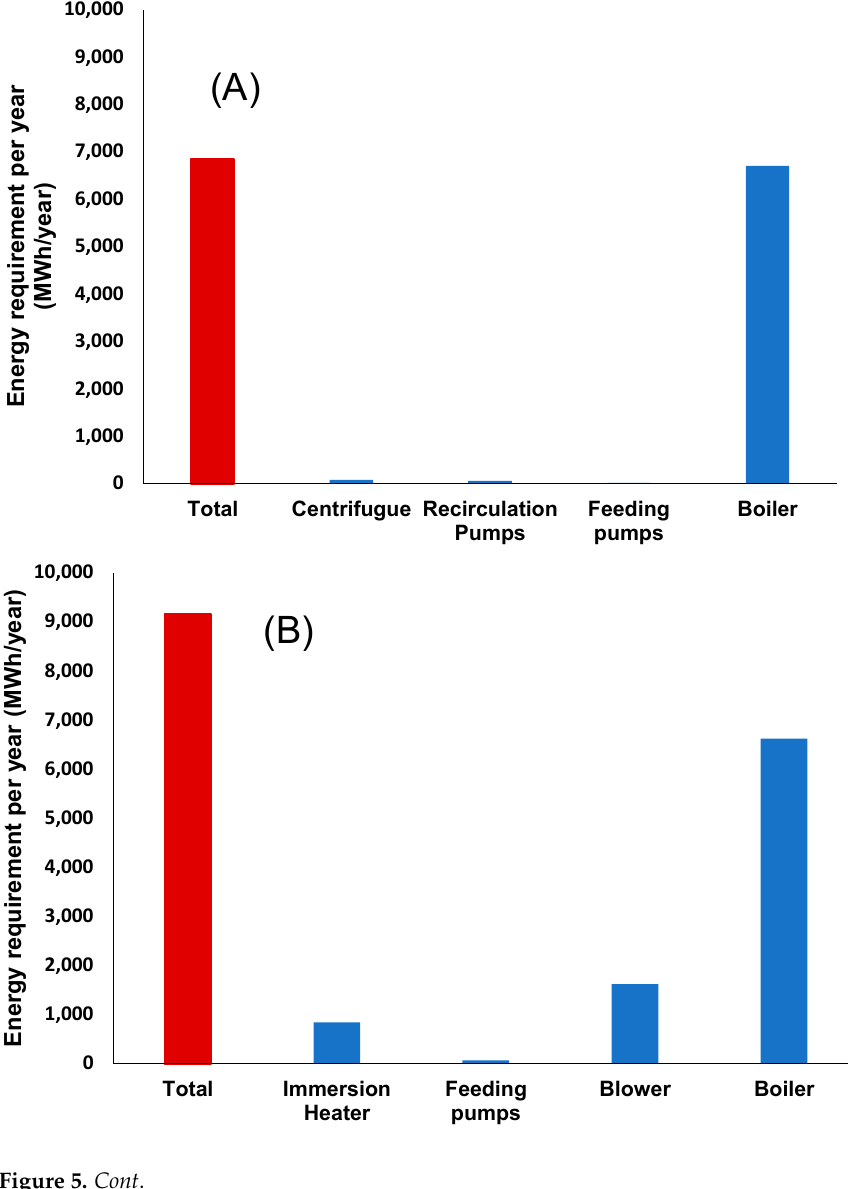
Figure 5. Annual energy requirements for: ( A ) thermal pre-treatment; ( B ) micro-aerobic pre- treatment of waste-activated sludge without thickening; ( C ) micro-aerobic pre-treatment of thickened waste-activated sludge. Micro-aerobic pre-treatment (Figure 5B) needs around 9.2 GWh year − 1 in order to pre- treat 48 Tons of TS per day − 1 of waste-activated sludge (21 kWh m − 3 sludge) which is 32% more than the thermal pre-treatment alternative. This value is explained by the high volume of waste-activated sludge needed (1200 m 3 of waste-activated sludge at 40 g TS L − 1 ). Nevertheless, if thickened waste-activated sludge uses the same concentration as thermal pre-treatment, annual energy requirements decrease considerably (Figure 5C). As a result, it needs 2.8 GWh year − 1 (25 kWh m − 3 sludge) 60% for heating, and 30% for aeration purposes, meaning that around ~60% less energy is required annually in this alternative compared to thermal pre-treatment applied to the same sludge.